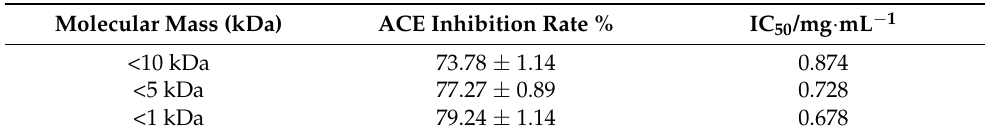
Table 1. ACE inhibition rate and IC 50 of ultrafiltration fractions in Camella vietnamensis meal protease